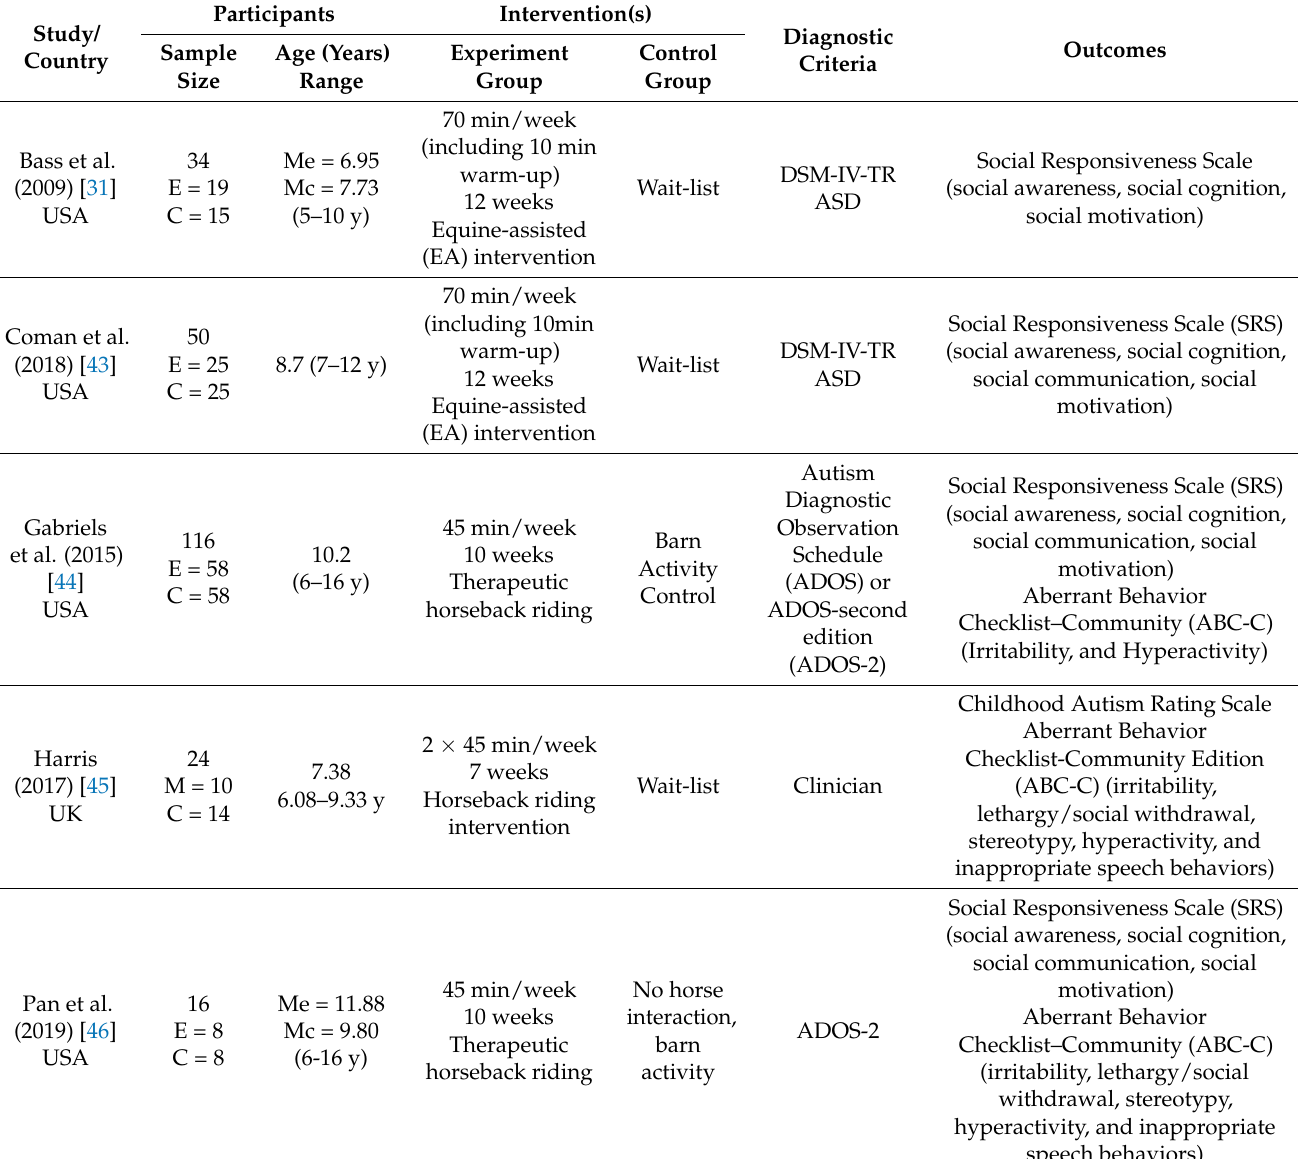
Table 1. Characteristics of randomized controlled trials in the meta-analysis